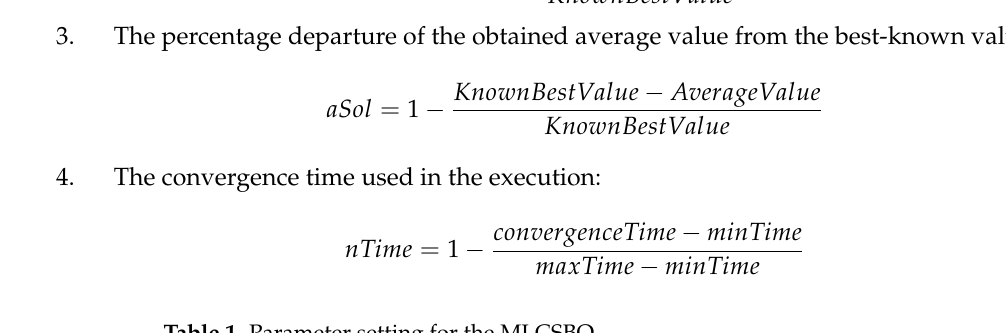
Table 1. Parameter setting for the